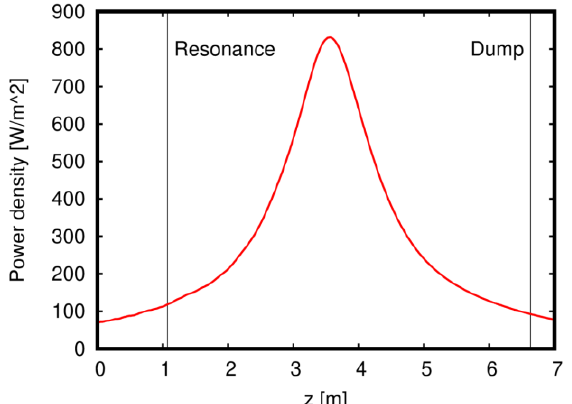
Fig. 10. Power density at the axis of the U1 beam after the mirror UA for a total beam power of 1 W.